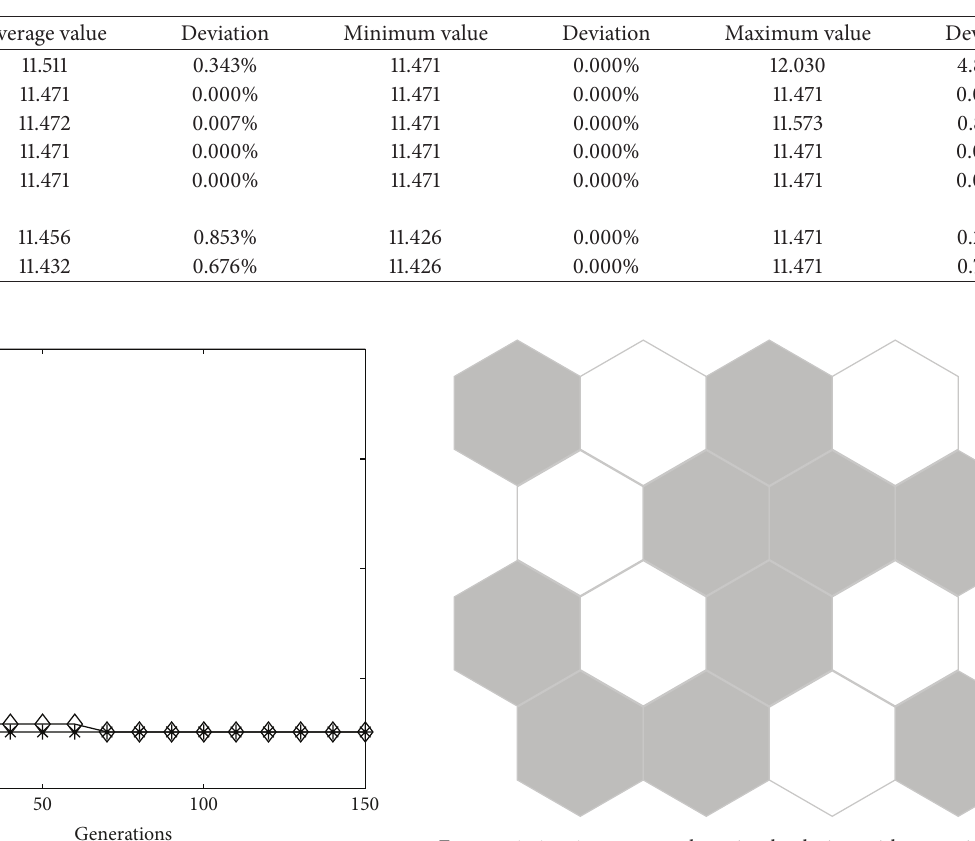
Table 4: Results for the 6 × 6 network.